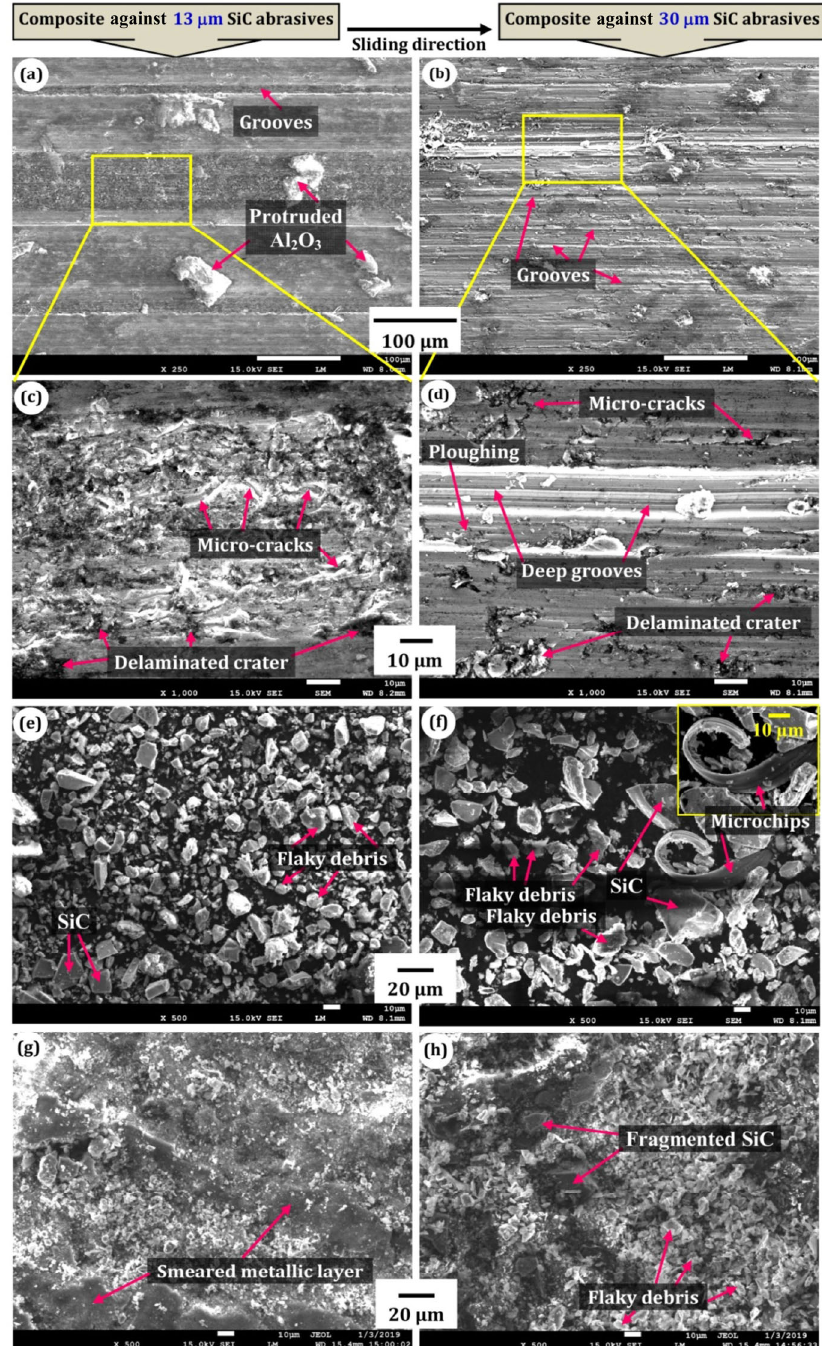
Fig. 4 FE SEM images illustrating the effects of size of SiC abrasives on the characteristics of worn surfaces (a − d), generated debris (e–f), and abraded SiC emery papers (g–h) for composite under the load of 40 N, sliding distance of 20 m, and sliding velocity of 0.5 m·s − 1